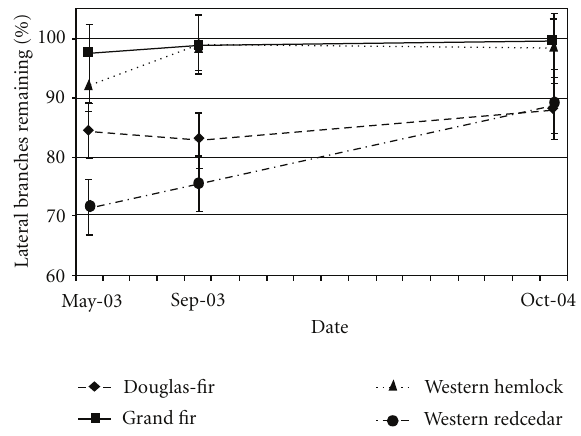
Figure 2: Percent of lateral branches remaining due to deer brows- ing for four conifer species planted in contiguous plots. Bars repre- sent one standard error of the mean.